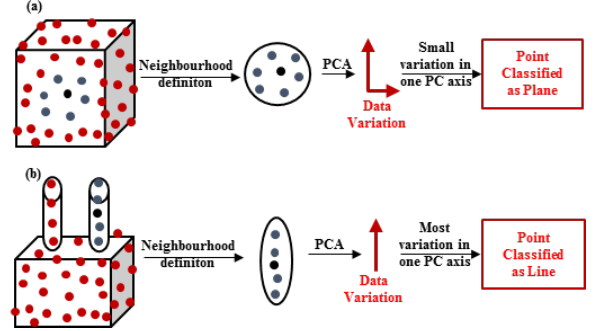
Figure 1. Classification of accumulated point clouds into a) planar surface; b) linear features In order to illustrate the benefits of using robust PCA over classical PCA, in particular for the identification of mixed pixels, a point cloud comprising four adjacent planes scanned from a single instrument location was simulated. Random errors were added to the data using the specifications of the Leica HDS6100 TLS 3 , the instrument used to collect real data for this research. Mixed pixel artefacts were added between two of the planes using the following equation: